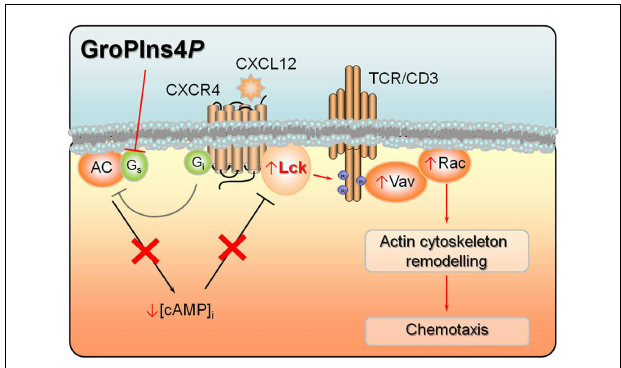
FIGURE 2 | Convergence of signals by CXCL12 and GroPIns4 P on adenylate cyclase activity . CXCL12 binding to its cognate receptor CXCR4 leads to activation of Lck, which stably interacts with the receptor. Lck in turn phosphorylates multiple tyrosine residues in the cytosolic tails of the TCR/CD3 complex, thereby triggering a signaling cascade involvingVav activation and eventually actin cytoskeletal rearrangements. Lck activity is further potentiated by CXCR4-dependent stimulation of Gi protein which, by inhibiting adenylate cyclase, lowers the levels of intracellular cAMP, resulting in decreased PKA-dependent activation of Csk, a negative regulator of Lck. GroPIns4 P potentiates migratory signaling by CXCL12 by blocking the activity of Gs protein, thereby further lowering adenylate cyclase activity and hence the intracellular cAMP levels and contributing to Lck activation. Phosphorylation states and events are shown as small blue circles. Activation events are shown as arrows, inhibition events as truncated